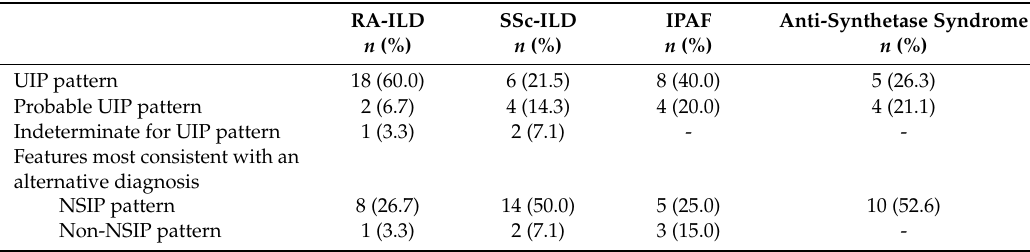
Table 3. Relation between HRCT pattern and the main AD-ILDs of this